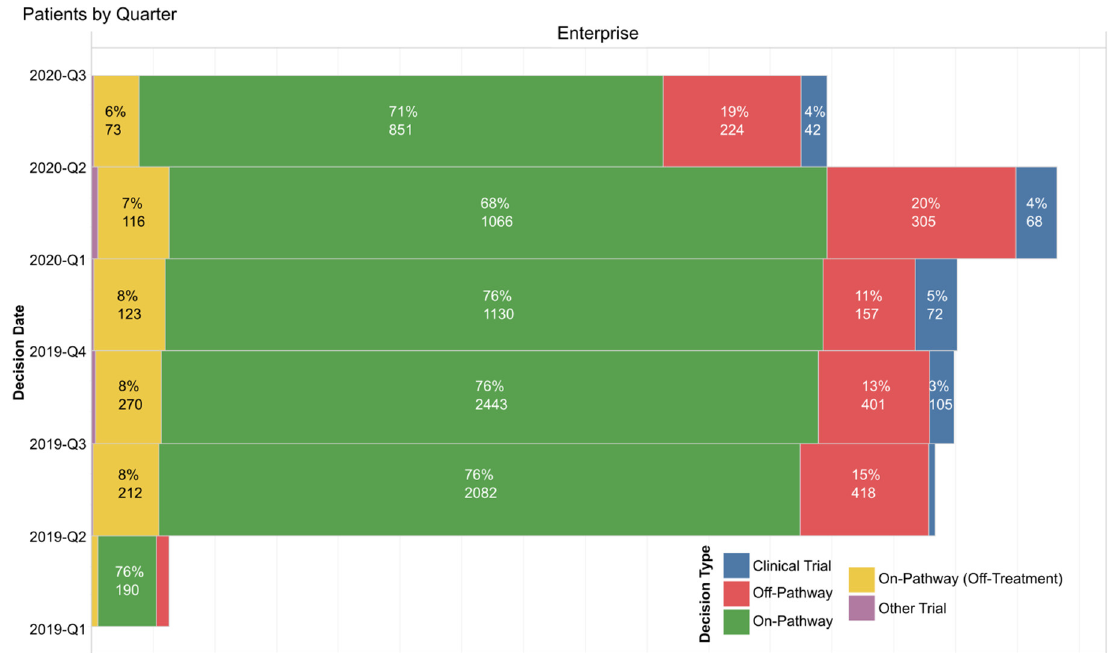
Figure 6. Individual patients seen by radiation oncologists by the enterprise per quarter since ClinPath pathways were initiated for radiation therapy in Q1 of 2019. The numbers represent the number of individuals with a decision made each quarter who are: on therapy with a non-pathway diagnosis, shown as “other trial” (purple), were on a pathway but went off treatment (yellow) that quarter, on a pathway treatment (green), are off treatment (light blue), are on an off-pathway treatment, (red) or on a clinical trial (dark blue) for an on-pathway disease.